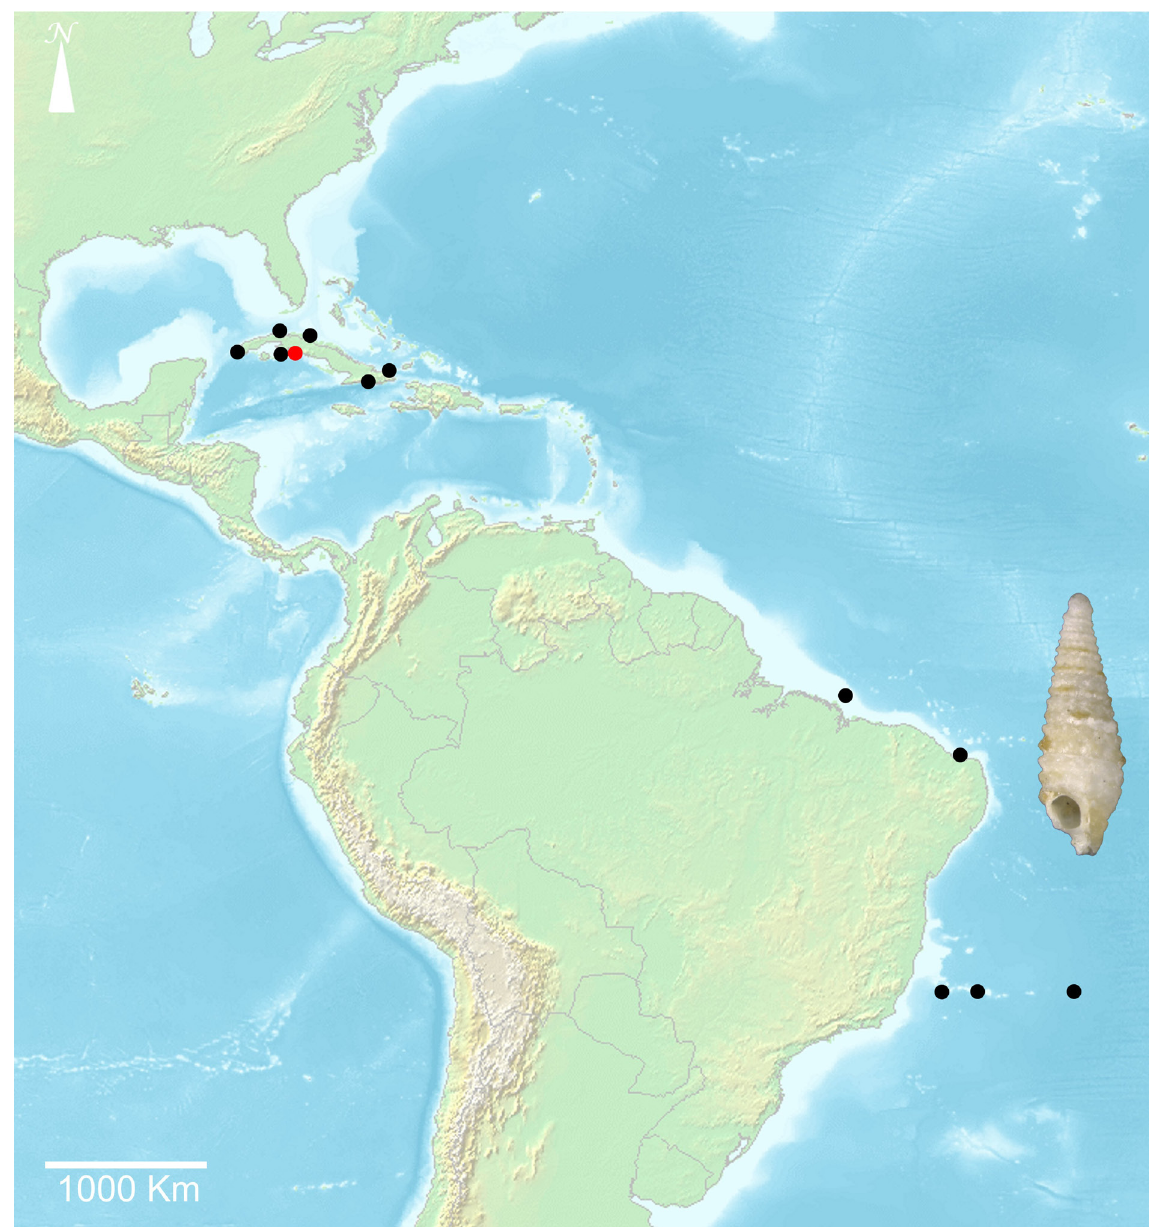
Fig. 48. Distribution map of Iniforis carmelae Rolán & Fernández-Garcés, 1993; red circle = type